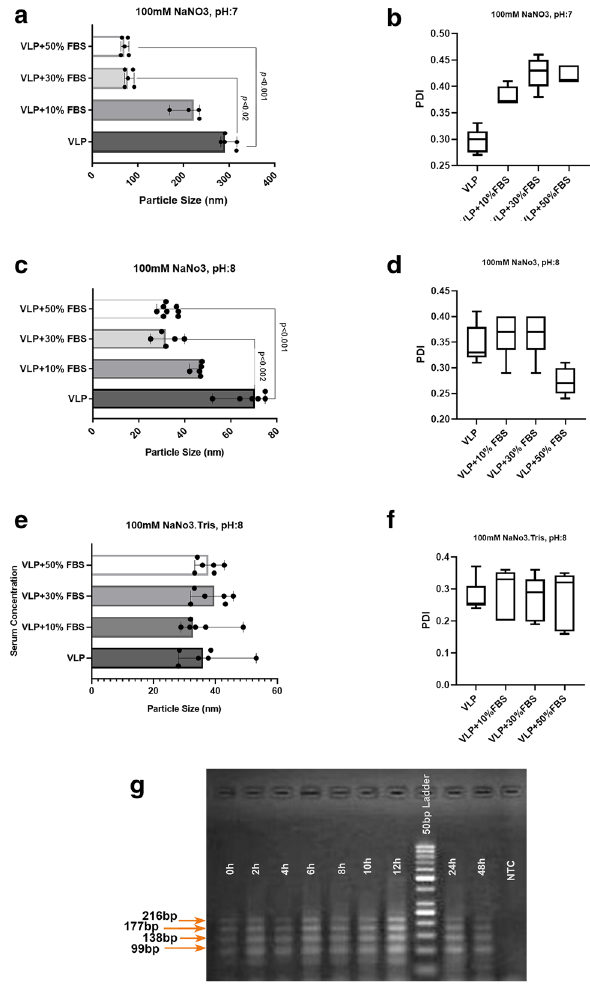
Figure 5. VLPs prepared in NaNO3-Tris buffer were stable in the presence of serum. Size and PDI of particles were evaluated for VLP suspension in different serum concentrations (10%, 30%, and 50%) after 1-h incubation at 4 °C. ( a , b ) 100 mM NaNO3 (pH: 7), ( c , d ) 100 mM NaNO3 (pH: 8), ( e , f ) 100 mM NaNO3-Tris (pH: 8). Results are shown as median with range, p < 0.02, p < 0.001, p < 0.002. ( g ) Gel electrophoresis for RT-PCR fragments of shRNAs extracted from VLP samples that were incubated at 37 °C for 0 h, 2 h, 4 h, 6 h, 8 h, 10 h, 12 h, 24 h, and 48 h time points in NaNO3-Tris (pH: 8) and 50% of